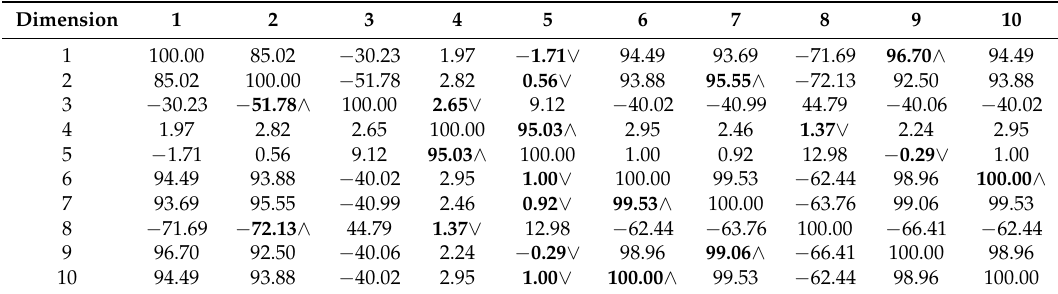
Table 5. Pearson correlation matrix for 10D Feature (%). In each line, the symbol ( ∧ ) indicates the highest correlation and ( ∨ ) indicates the lowest correlation. The highest and lowest values of each segment are